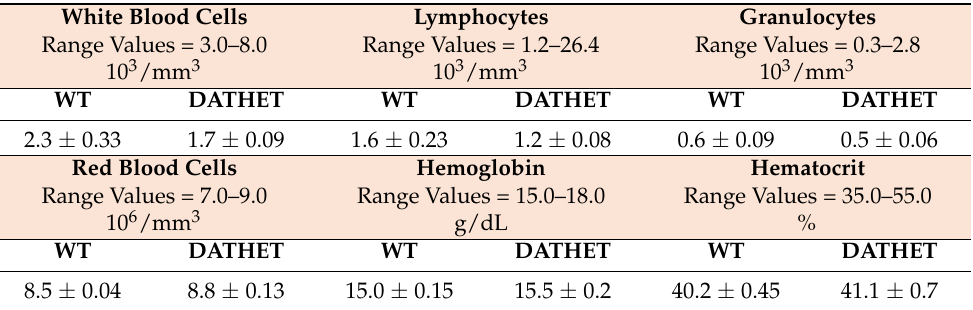
Range Values = 15.0–18.0